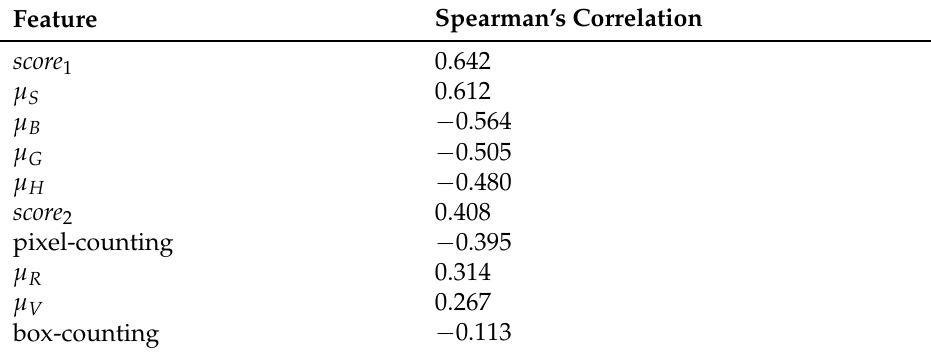
Figure 5. Example of the predictions obtained by the regression model on three samples. For each image, we report the assigned Efron score and our method’s predicted score. We would like to stress that the predicted scores are floating point numbers and therefore they are more descriptive for the redness evaluation, ensuring a finer redness grading scale of values. Table 2. Spearman’s correlation coefficient scores of single features in relation to the Efron grading scale values, ranked from the highest to the lowest. The analysis of the single feature correlation highlights an unbalanced informative power in the prediction of the Efron scale values. Only three features have a correlation coefficient greater than 0.55 (in absolute